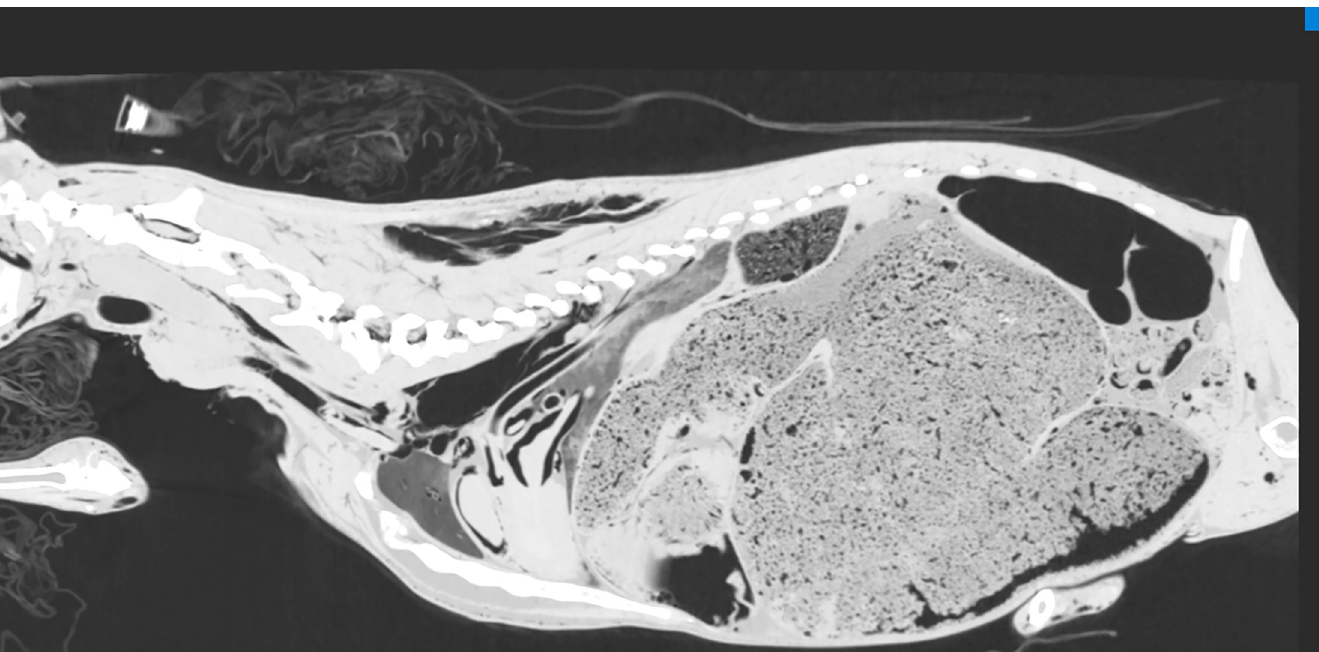
Fig 8. CT reconstruction in parasagittal plane after intra-arterial air inflation; lung window. Air-filled blood vessels and heart chambers visible. Furthermore, subcutaneous emphysema in the region of withers and neck, pneumothorax and extraperitoneal emphysema due to air efflux from the vessels.